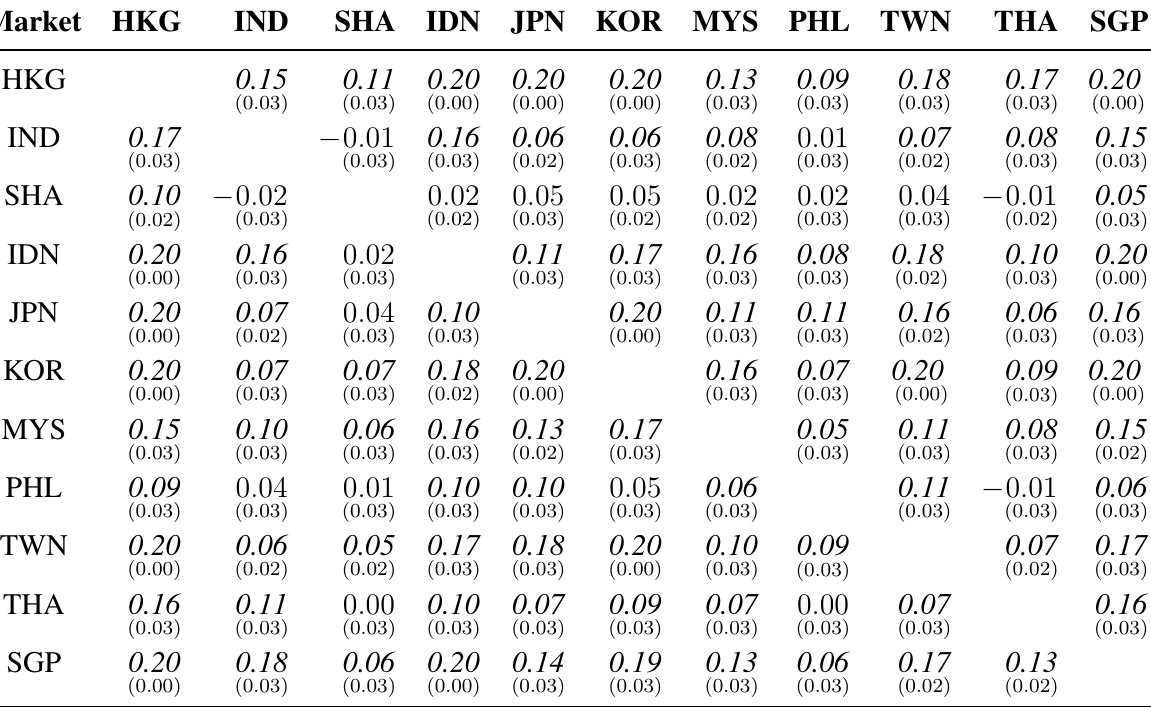
Table 11. Estimation results of  in the bivariate SV model.